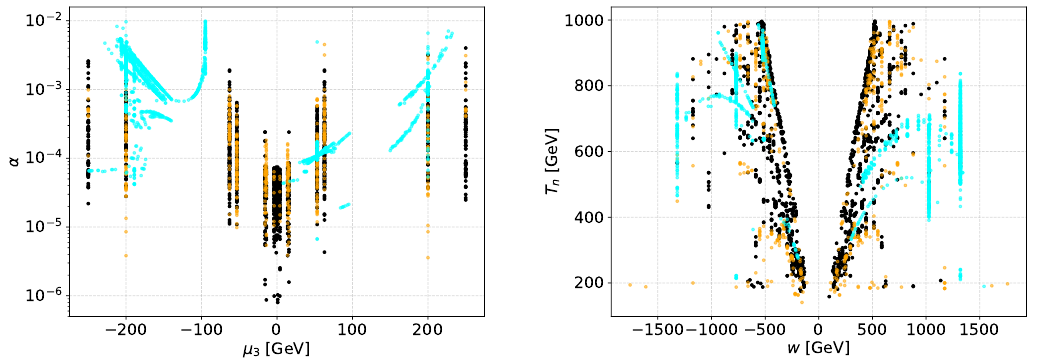
Figure 11 . Dependence of phase transition parameters on potential parameters. The points from the re(cid:12)ned scan are shown in cyan. The orange points are excluded and the black points are allowed by the XENON1T constraints. All other constraints are